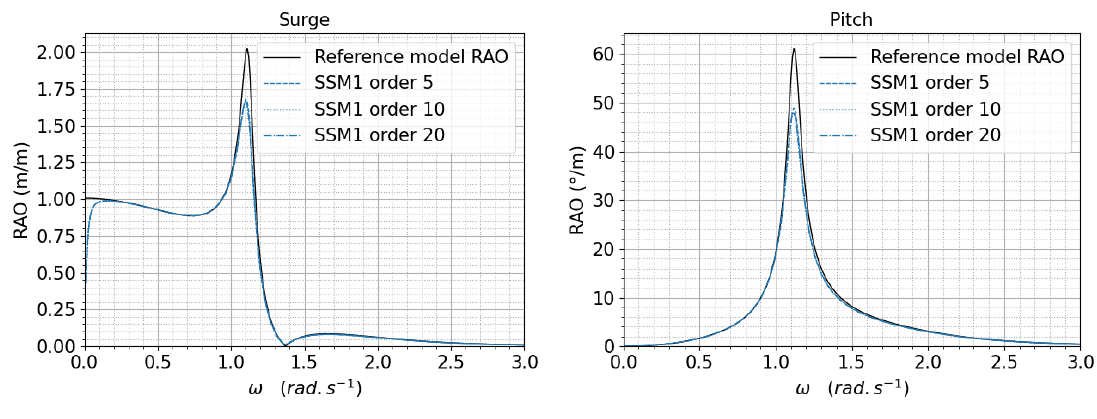
Figure 5. Comparison between SSM1 and the reference RAO for surge and pitch